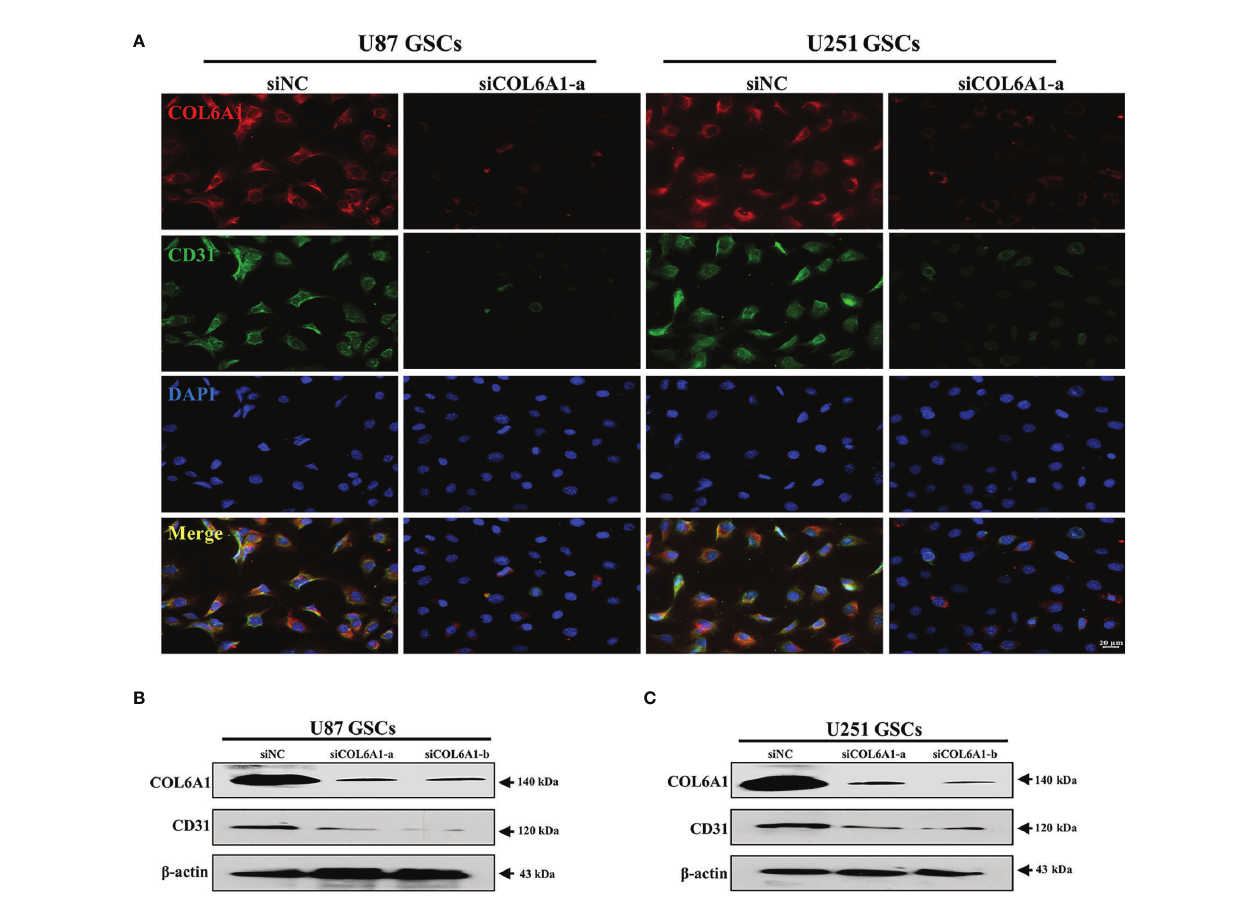
FIGURE 5 | COL6A1 regulated GSCs differentiate toward ECs (A) Immuno fl uorescence analysis of COL6A1 and CD31 in U287 and U251 GSCs infected with siNC and siCOL6A1-a after GSCs induced transdifferentiation in hypoxia(scale bar=20 m m). (B, C) Western blot analysis of CD31 and COL6A1 in U87(B)or U251(C) GSCs transfected with siNC, siCOL6A1-a and siCOL6A1-b after 3 days of transdifferentiating